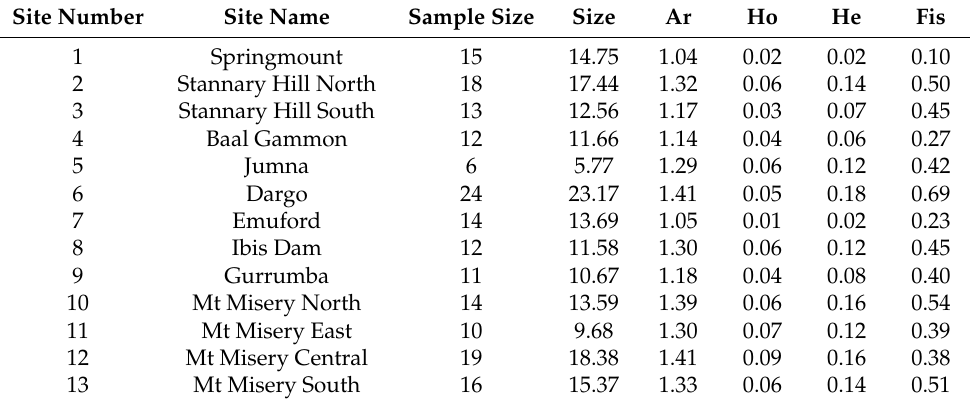
Table 2. Diversity estimates for 13 populations of A. purpuereopetala . Ar = allelic richness; size = av- erage number of individuals genotyped per locus per population Ho = Observed heterozygosity, He = expected heterozygosity, Fis = inbreeding coefficient. Site numbers are as they appear on the map (Figure